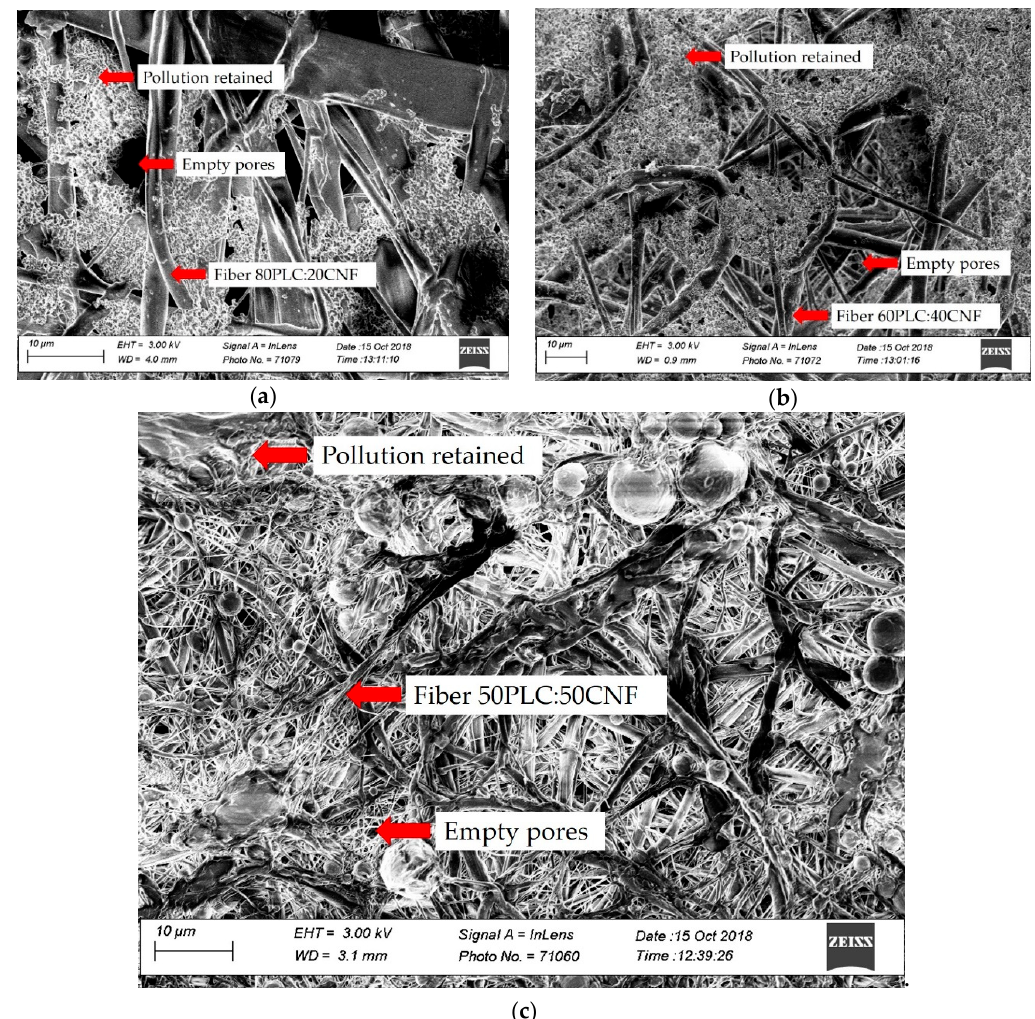
Figure 7. SEM images after filtration of tap water using electro-spun membranes of PCL: CNF ( v / v ) ratios: ( a ) 80:20, ( b ) 60:40, and ( c ) 50:50.